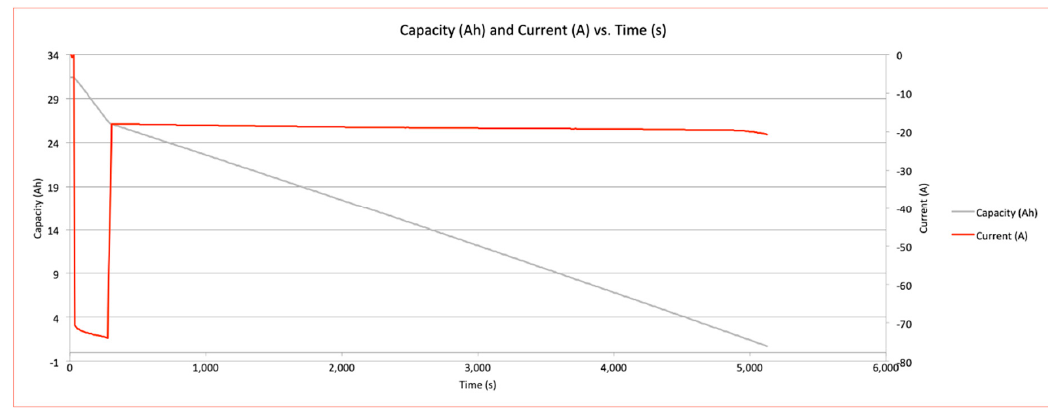
Figure 20. Battery pack test. Battery pack behavior under flight load profile.